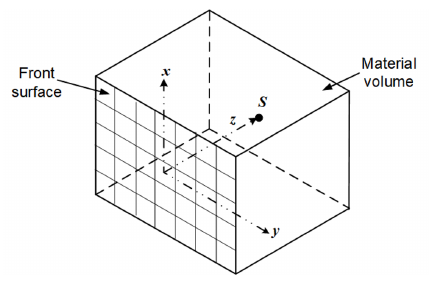
Figure 1. A point radioactive source buried in a section of a